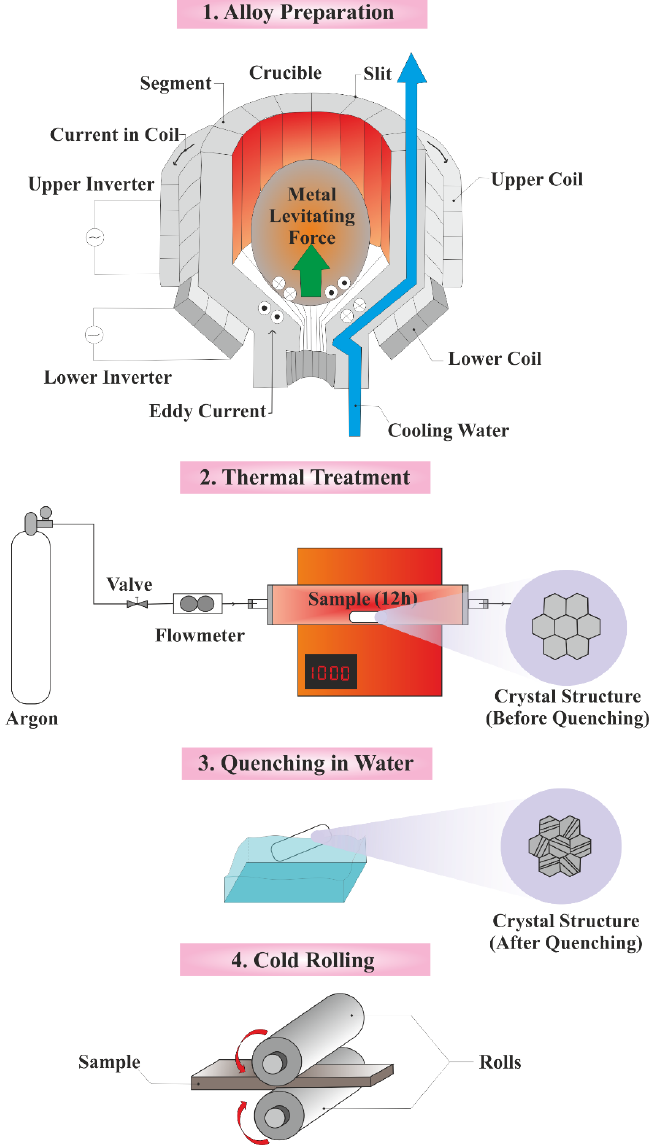
Figure 1. Step-by-step procedure for preparation of Ni- treated Ti: (1) The cold crucible levitation melting technique (CCLM) through which an alloy with a uniform composition is formed by an electromagnetic force. Using this method, metals with a high melting point are melted with no contamination, (2) Tube furnace in which the obtained alloy is homogenized at high temperature under high-purity argon atmosphere, (3) The specimens are quenched to achieve the favorable crystal phase, and (4) Cold rolling with the aim of achieving the favorable sample thickness (source: